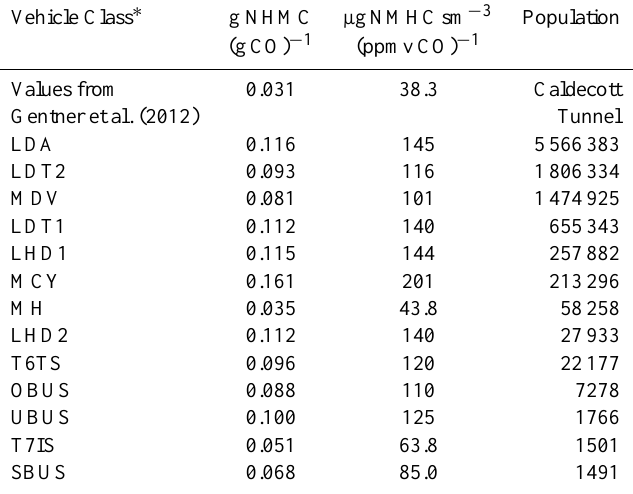
Table 3. Gasoline vehicle-specific emission ratios, EF NMHC /EF CO , predicted by EMFAC2011 (http://www.arb.ca.gov/emfac/) for the South Coast Air Basin in summer 2010. Emission ratios are based on daily CO and NMHC emission rates calculated by EMFAC2011. Emission ratios include all drive-cycle components (i.e., running, idle, start, diurnal evaporative, hot-soak evaporative, running evaporative, and resting evaporative). Rows are ordered in descending population. Numerical values in µgNMHCm − 3 (ppmvCO) − 1 columns are calculated using the conversion factor 1250µgCOsm − 3 (ppmvCO) − 1 . Note that the values predicted by EMFAC are higher than what is reported by Gentner et al. (2012) because they include products of incomplete combustion, evaporative emissions, and start emissions. Vehicle Class ∗ g